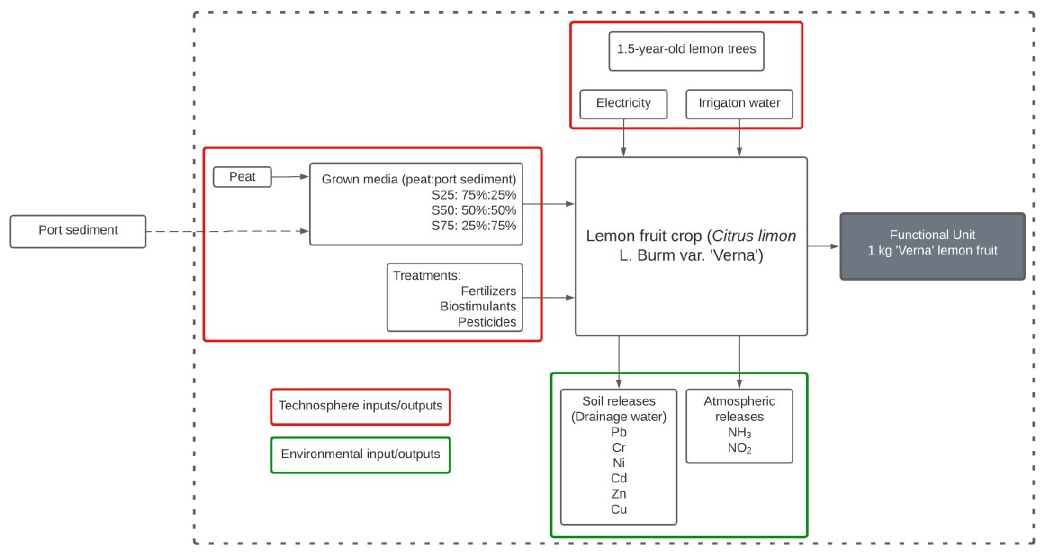
Figure 1. Scheme of the product system defined for this study.